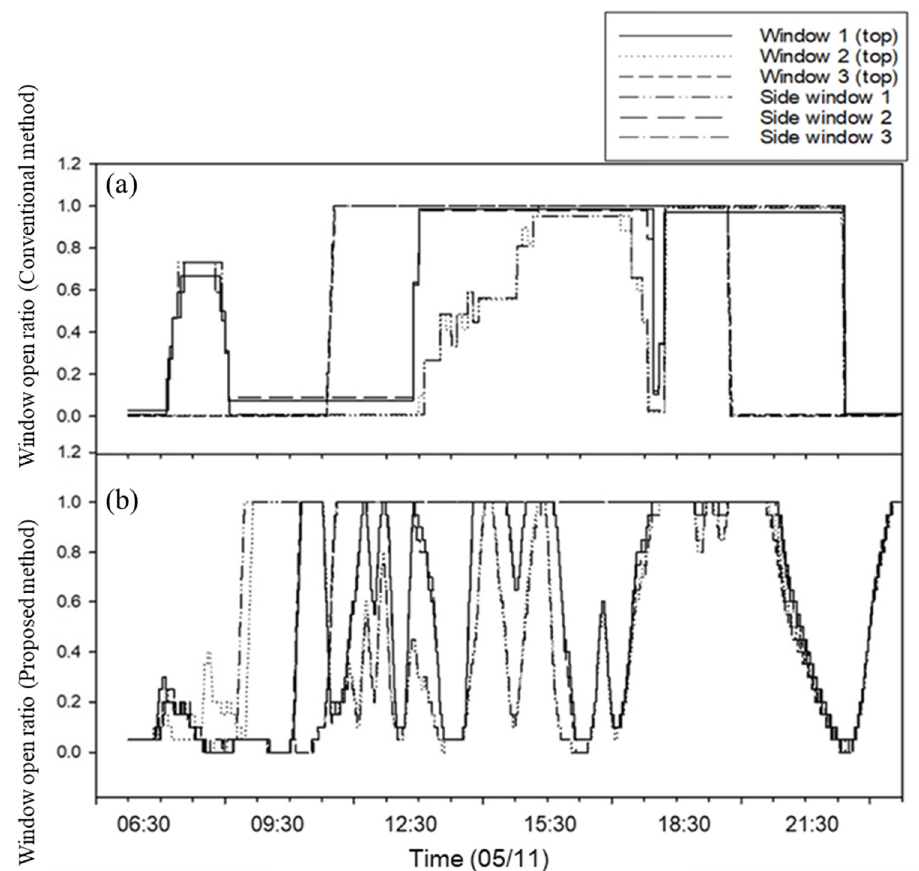
Figure 10. Comparison of window control history for the conventional method ( a ) and the proposed method ( b ) on 11 May.